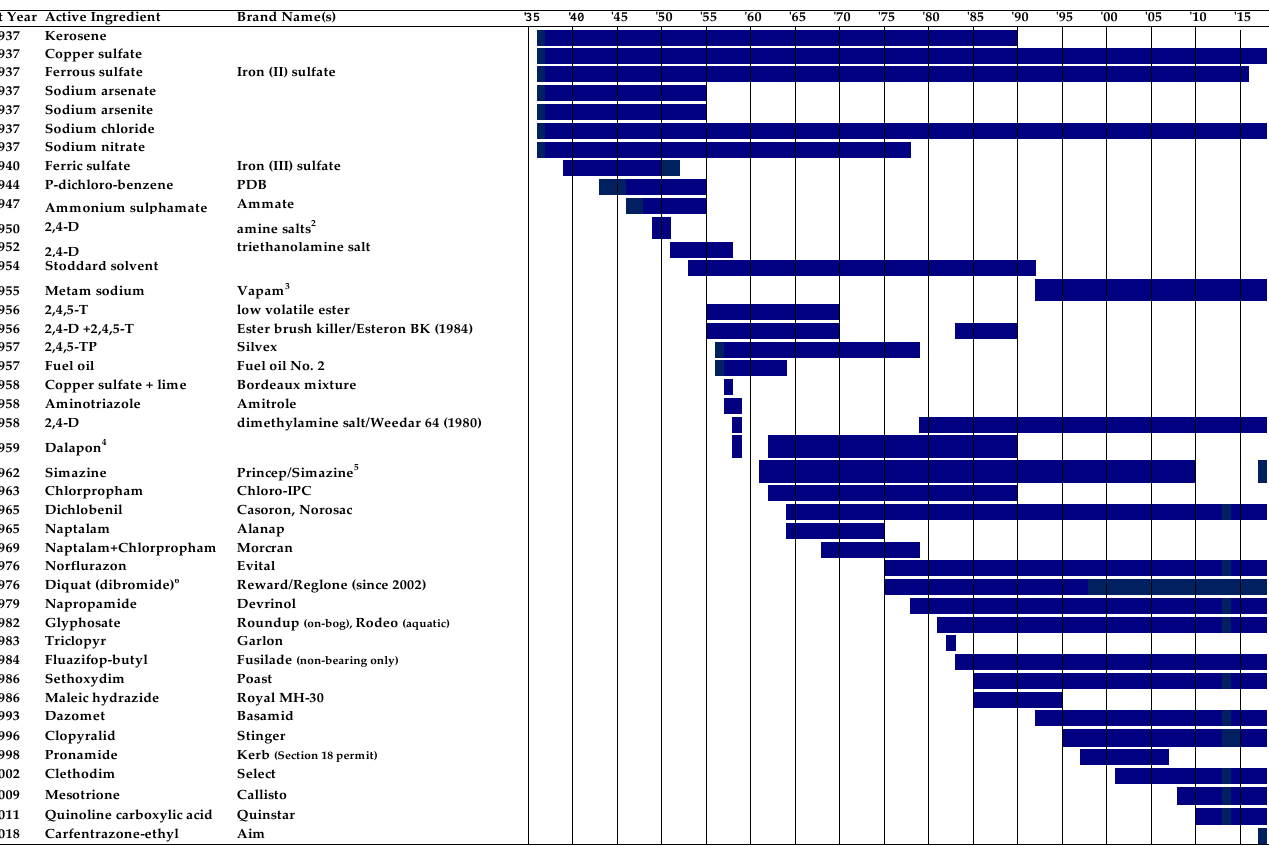
Figure 1. Historical listing of herbicides registered for use in cranberries, 1937–2018. Bar indicates years recommended and/or labeled for use; data derived from Massachusetts-based documents and personnel 1 . Although charts were not printed during 1942–1945, it is presumed that the compounds registered for use on cranberry remained registered during these World War II years.